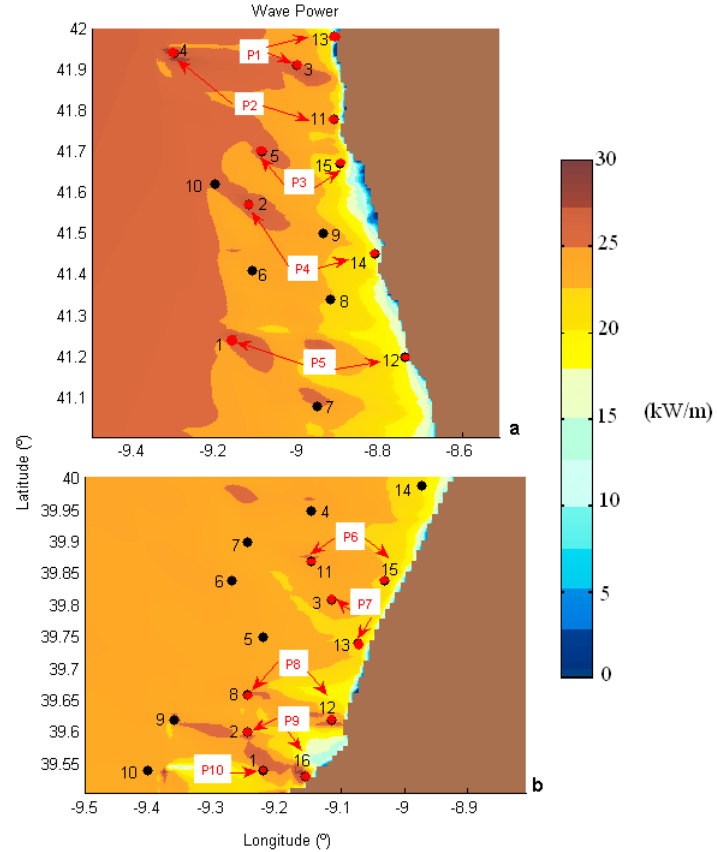
Figure 1. Distribution of the mean wave power for simulations from January 2009 to December 2011 in the two medium resolution computational domains. The positions of the reference points are also indicated; ( a ) northern computational domain (and the reference points denoted as the A-points); ( b ) central computational domain (and the reference points denoted as the B-points). The P-points represent the A and B points, respectively for which the bivariate diagrams were